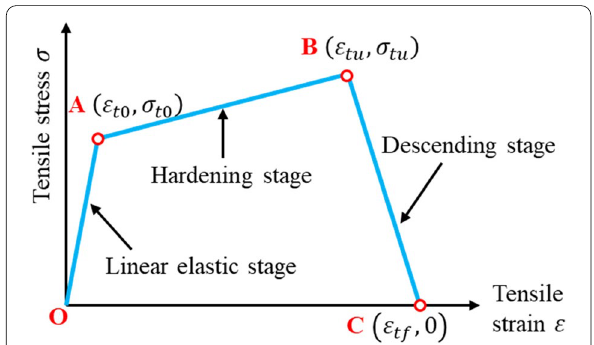
Fig. 3 Illustration of the tensile stress-strain constitutive model of HPFRCC with high